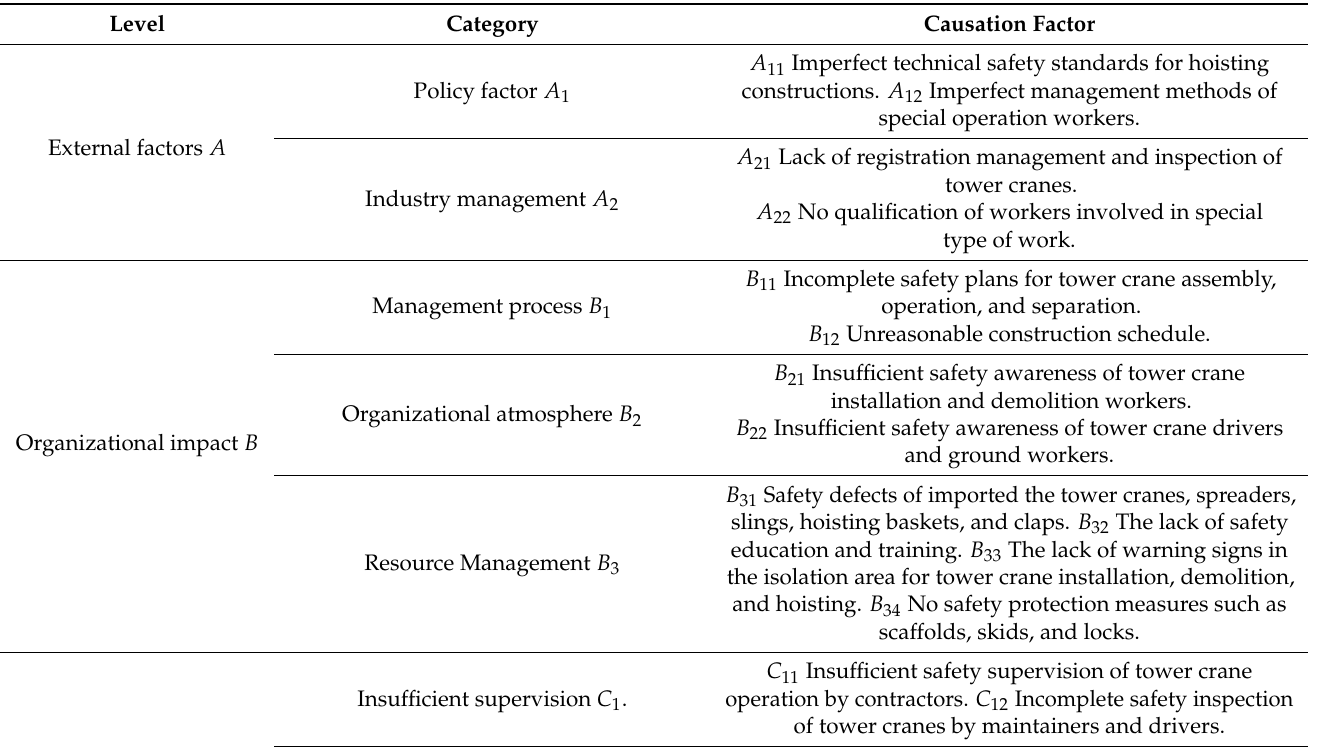
Table 1. Causation factors of prefabricated building hoisting construction accidents based on im- proved HFACS